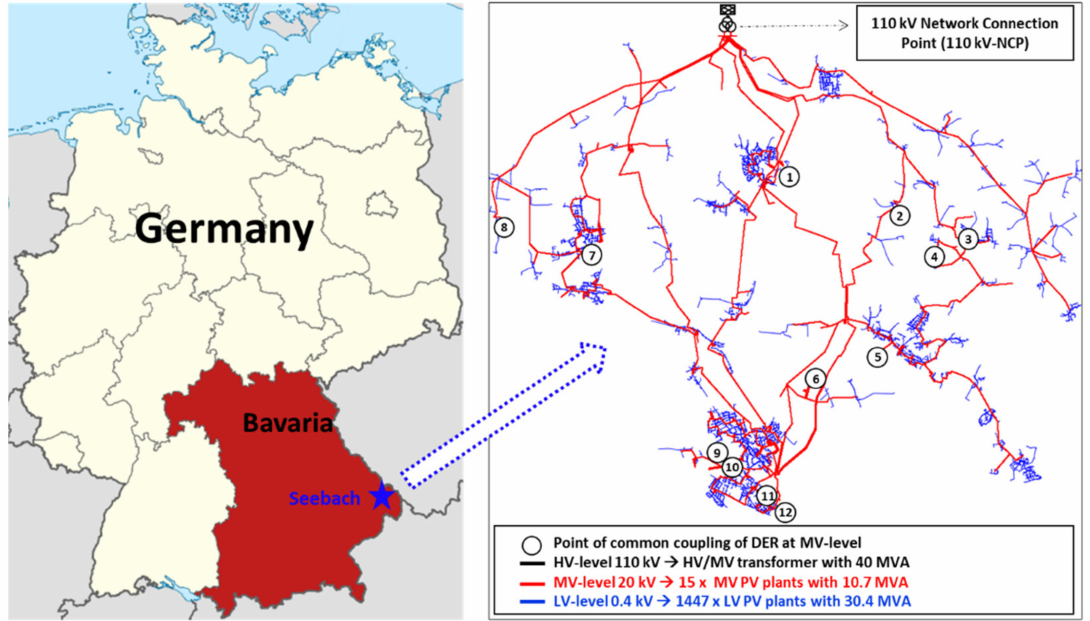
Figure 6. The applied multi-voltage-level grid model for the case study area Seebach.